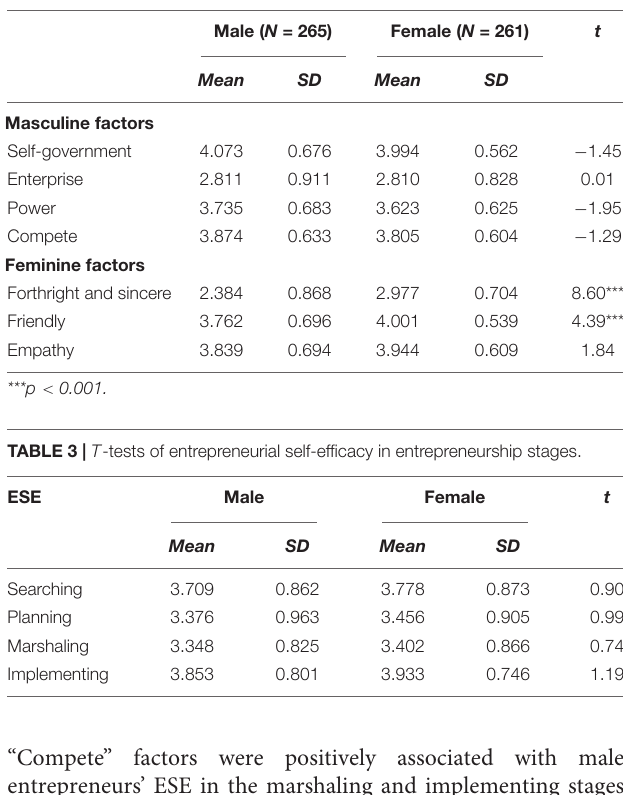
TABLE 2 | T -tests of gender role factors.